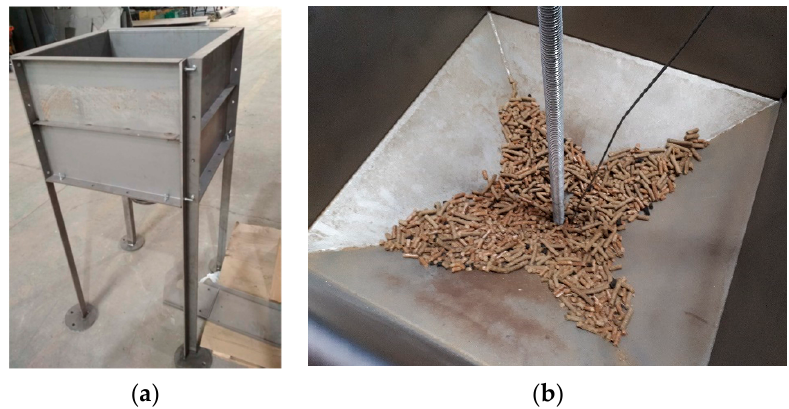
Figure 3. Solids storage: Silo main unit ( a ) and cylindrical bar ( b ).